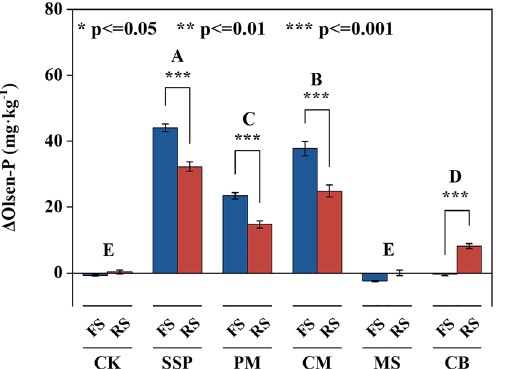
Figure 1. Changes in Olsen-P concentrations (ΔOlsen-P) in fluvo-aquic and red soils supplemented with different phosphorus sources during 70-day incubation. Values are means ± SE (n = 4). FS: Fluvo-aquic soils; RS: Red soils; CK: Control; SSP: Ca(H 2 PO 4 ) 2 ; PM: Poultry Manure; CM: Cattle Manure; MS: Maize Straw; CB: Cattle Bone Meal. Dissimilar uppercase letters denote significant differences among the P sources ( P <